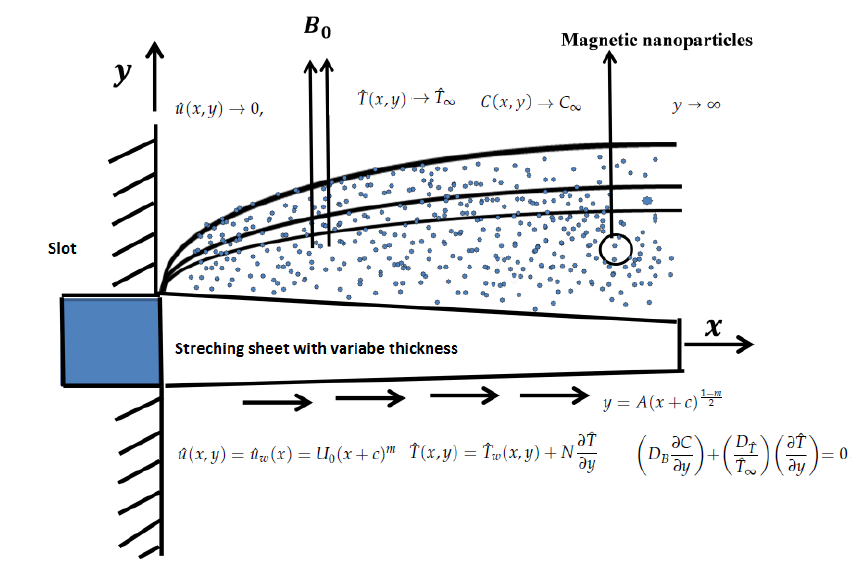
Figure 1. Geometry of the